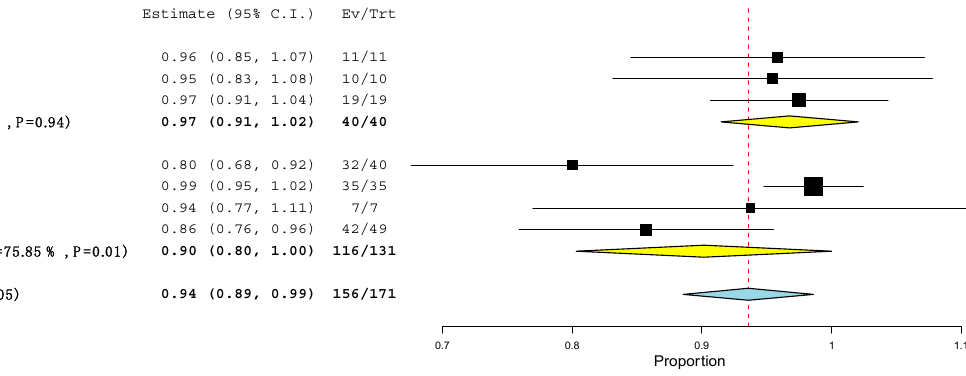
Figure 3. Sensitivity of 18 F-FES PET/CT at the level of patients across studies. When LBA was conducted, the sensitivity of 18 F-FES PET/CT and 18 F-FDG PET/CT at the time of first staging was 88% and 89% respectively, while at the time of restaging it was 81% and 98%, respectively (Figures 4 and 5). Interestingly, the sensitivity of 18 F-FES PET/CT at the time of restaging was significantly higher than that of the same procedure at the time of staging (Figure 4).